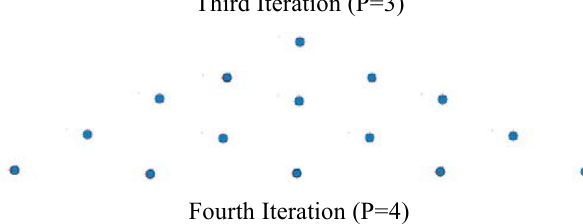
Figure 4. First four iterations of triangular planar fractal array antenna for an expansion factor of one.